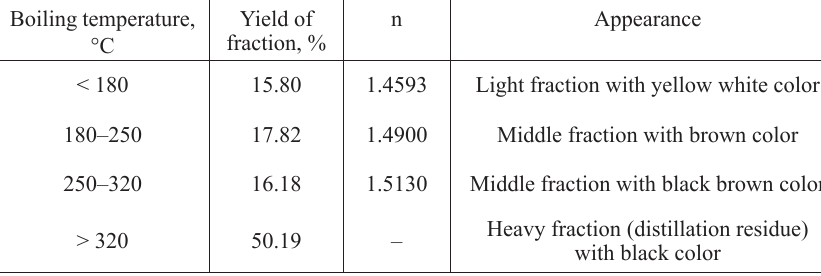
Table 4. The yields of distillation fractions of Uvurjargalant oil shale pyrolysis tar with different boiling temperatures Boiling temperature, Yield of n Appearance fraction, % °C < 180 15.80